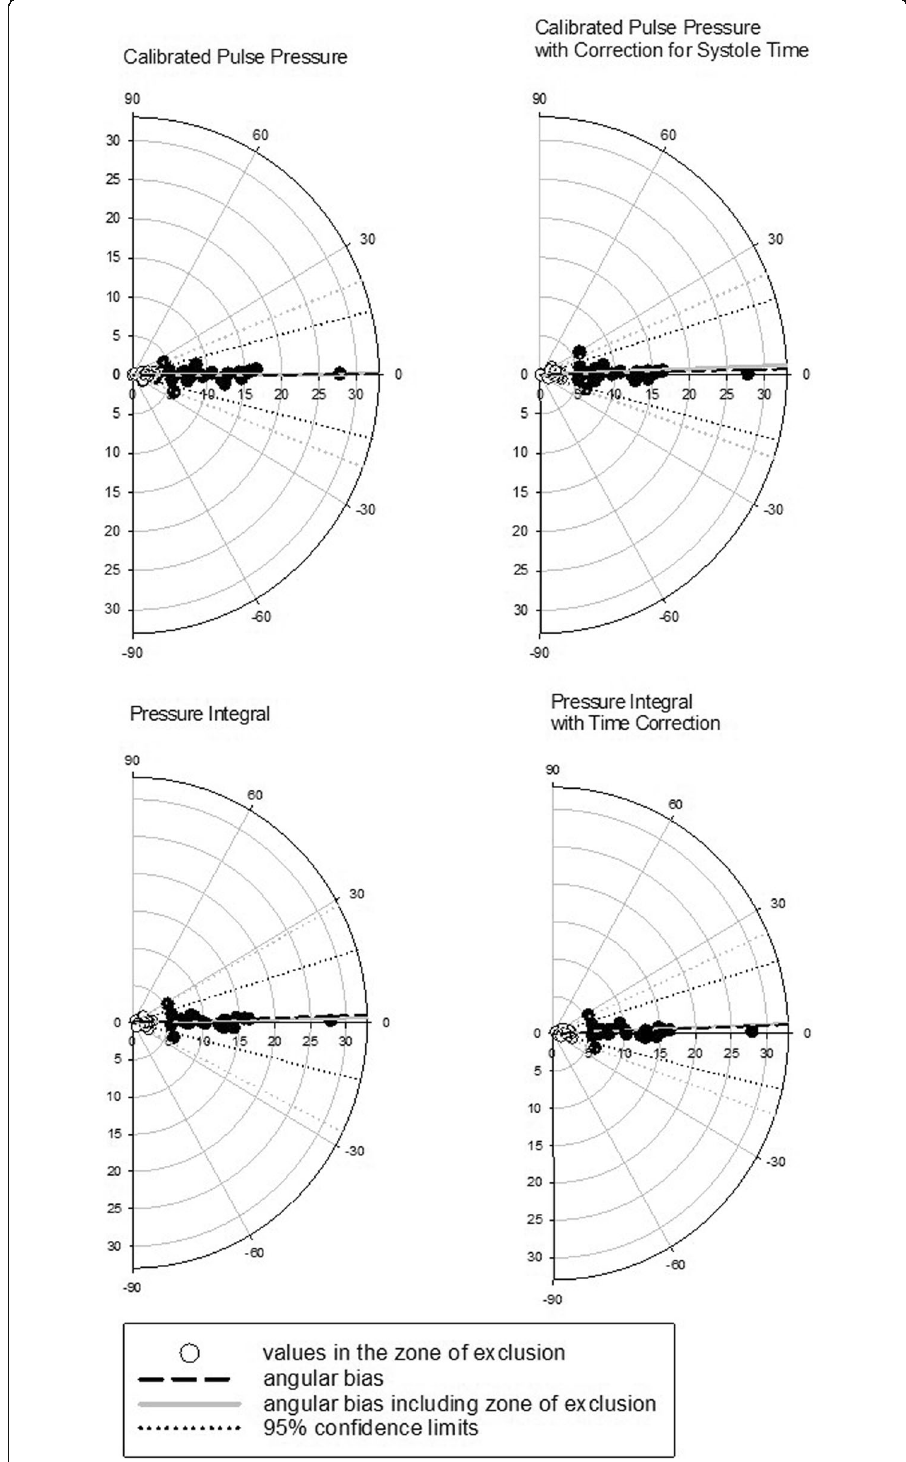
Fig. 4 Polar plots for trending, with the same data as Fig. 3. The central zone of exclusion contains values within the range of the least significant